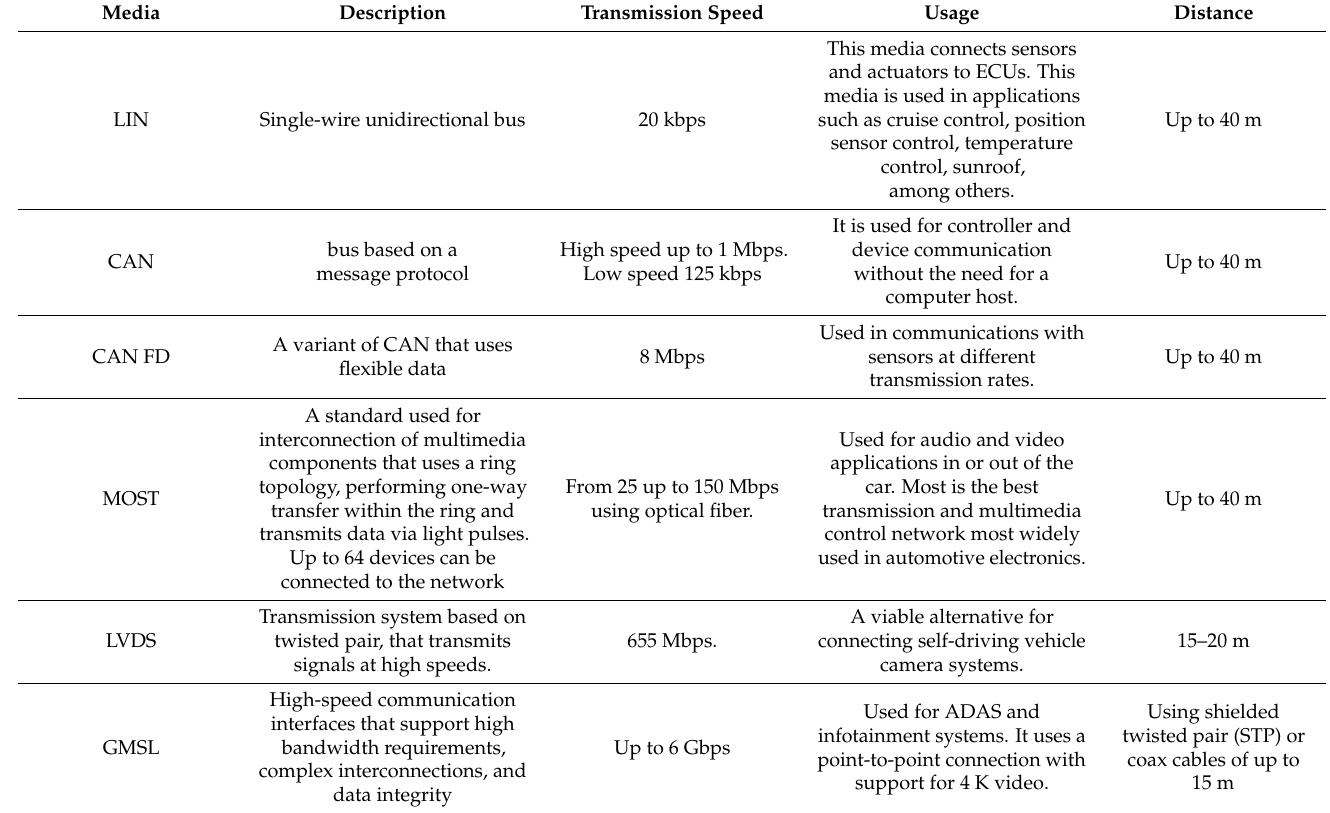
Table 1. Summary of autonomous vehicles’ communication